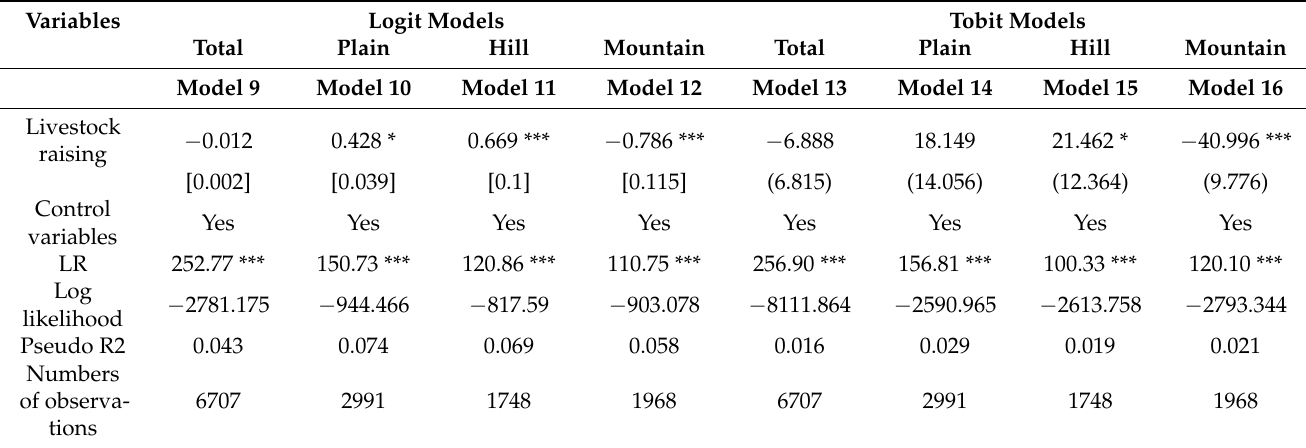
Table 4. Robustness test of Logit models and Tobit